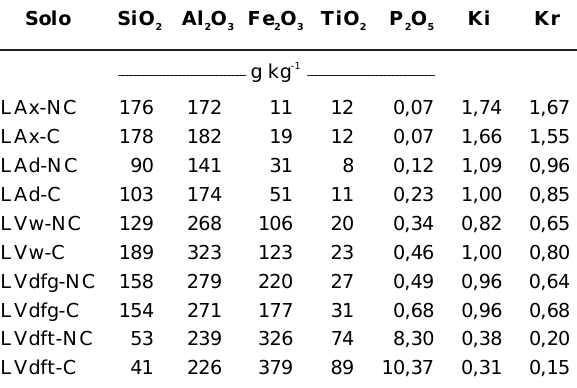
Quadro 3. Óxidos do ataque sulfúrico e índices Ki e